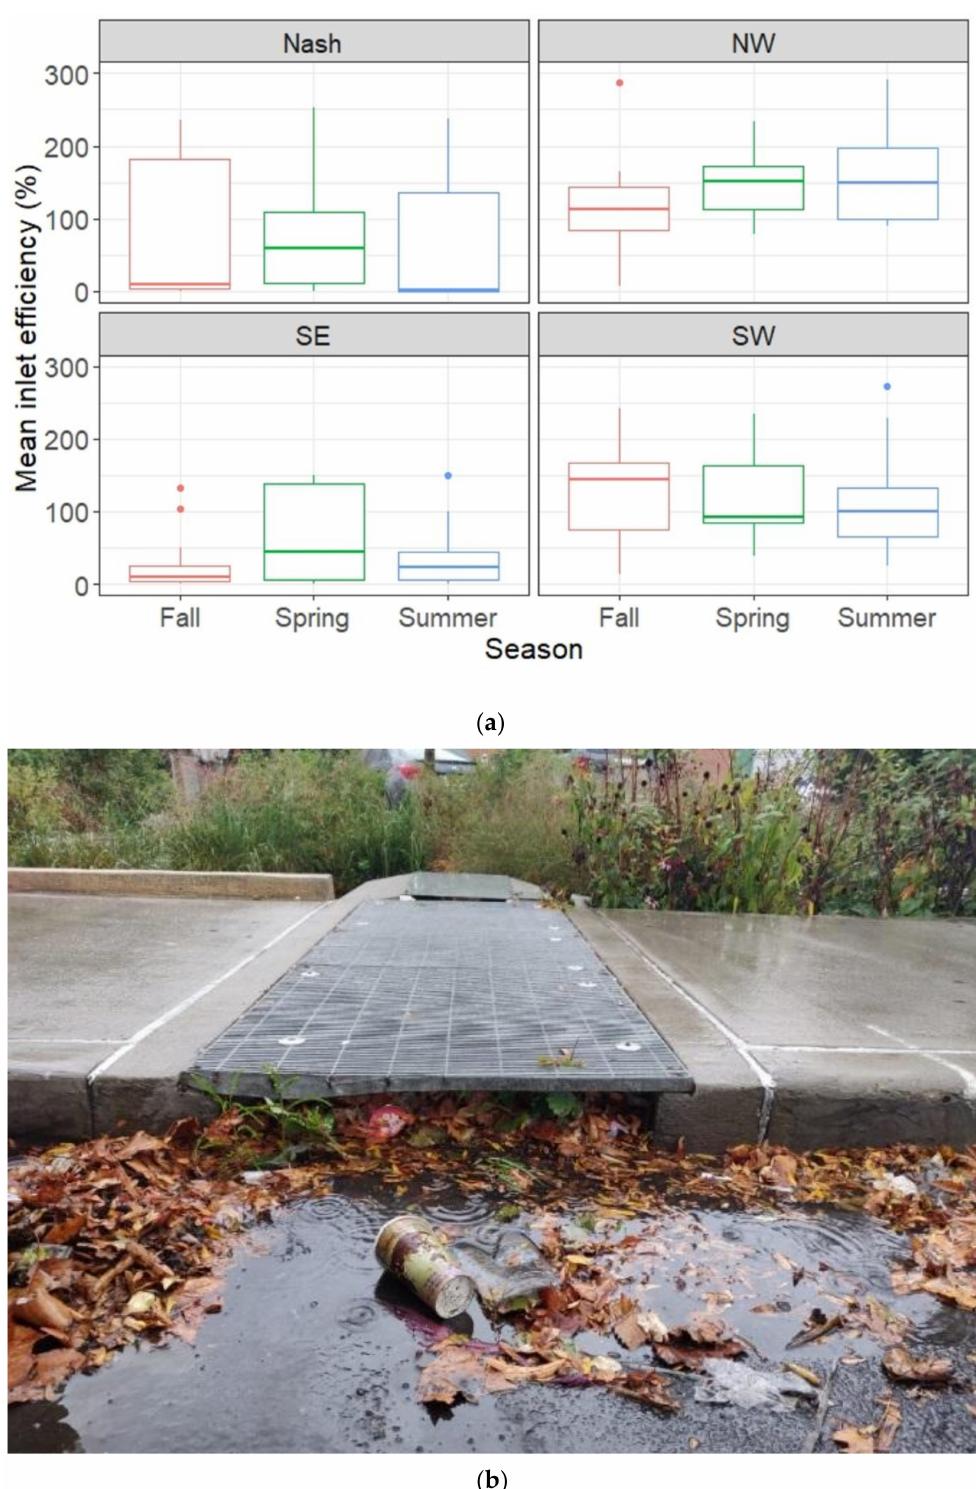
Figure 11. ( a ) Effect of season on mean inlet efficiency; ( b ) leaves collected during fall reducing mean inlet efficiency during